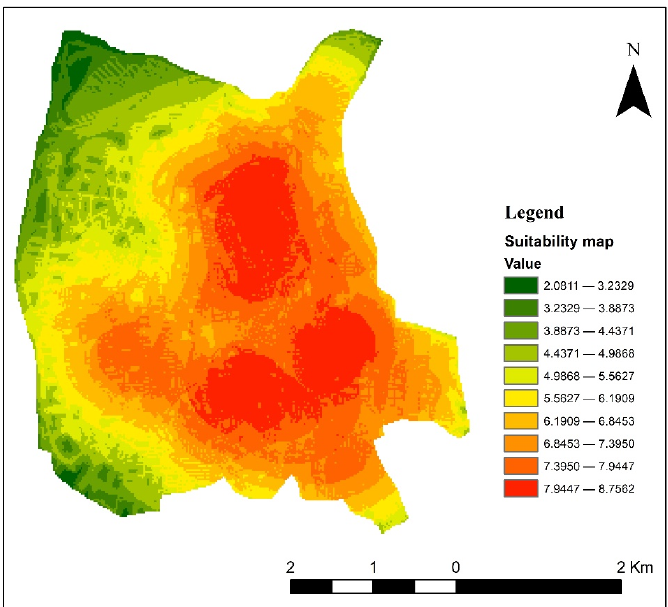
Figure 6. Suitability map for the vaccination centres.